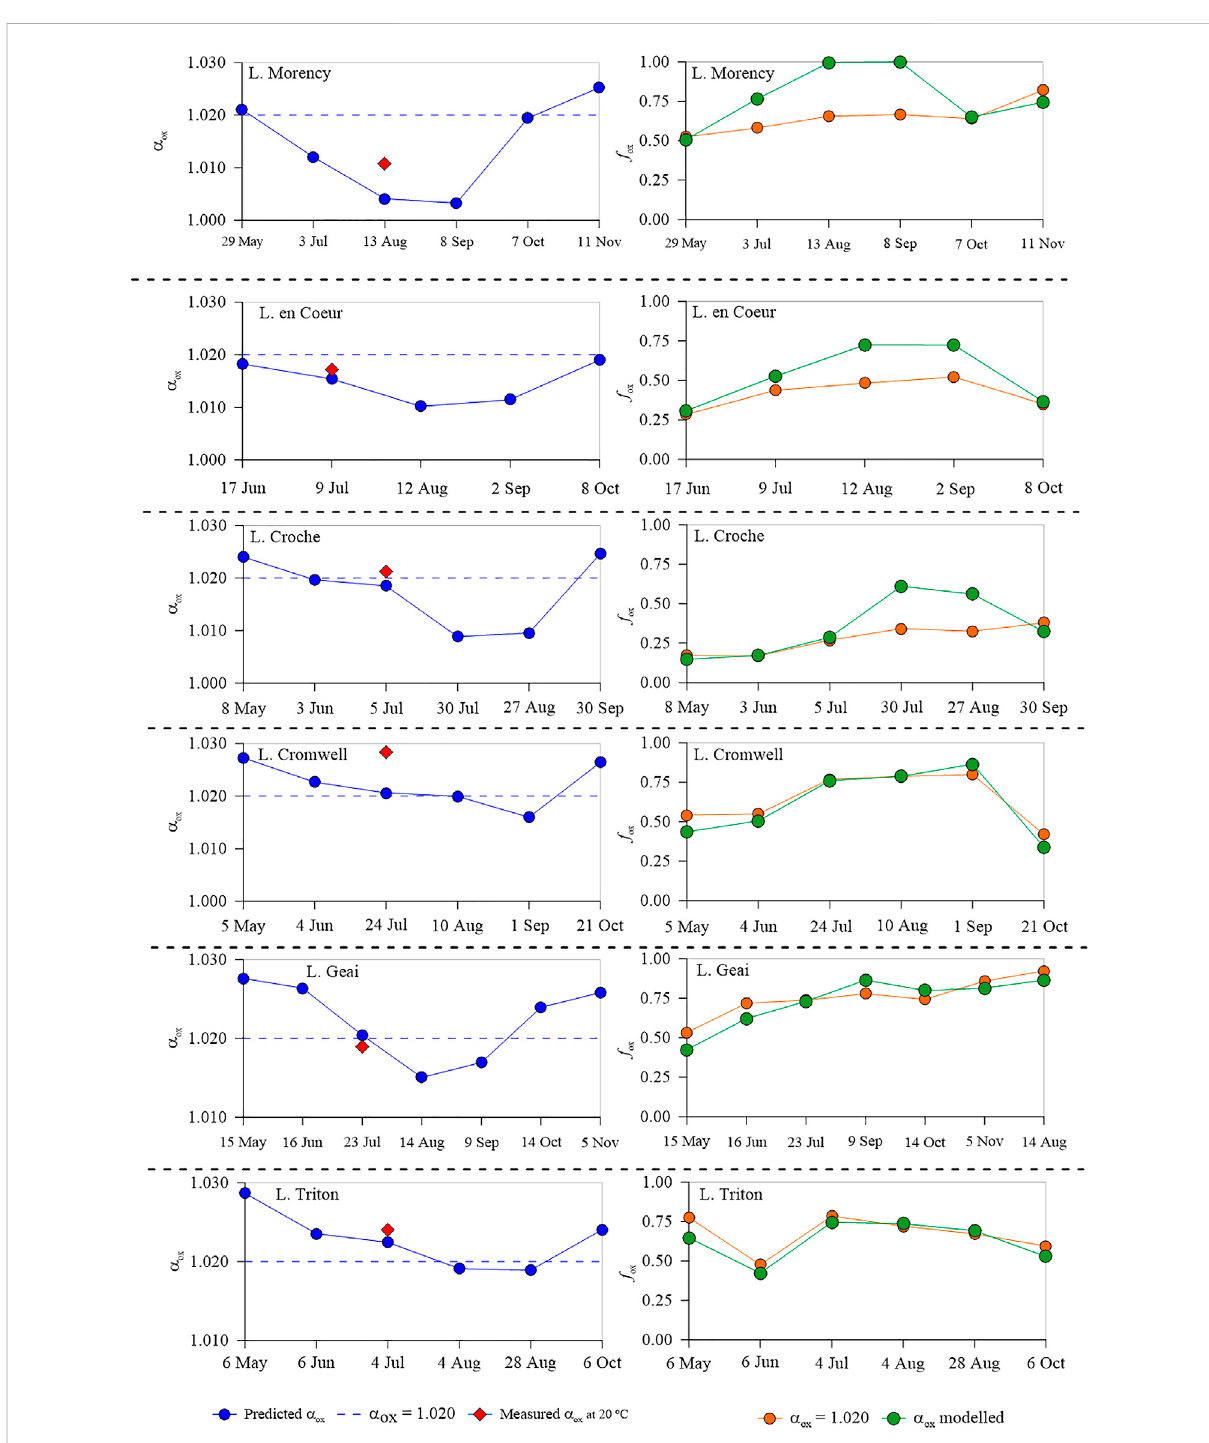
Seasonal variation inpredicted α ox (leftpanel) andfractionofCH 4 oxidised ( f ox )(right panel)estimatedusinga fi xed α ox of1.020orthemodelled α ox in the surface layers of each study